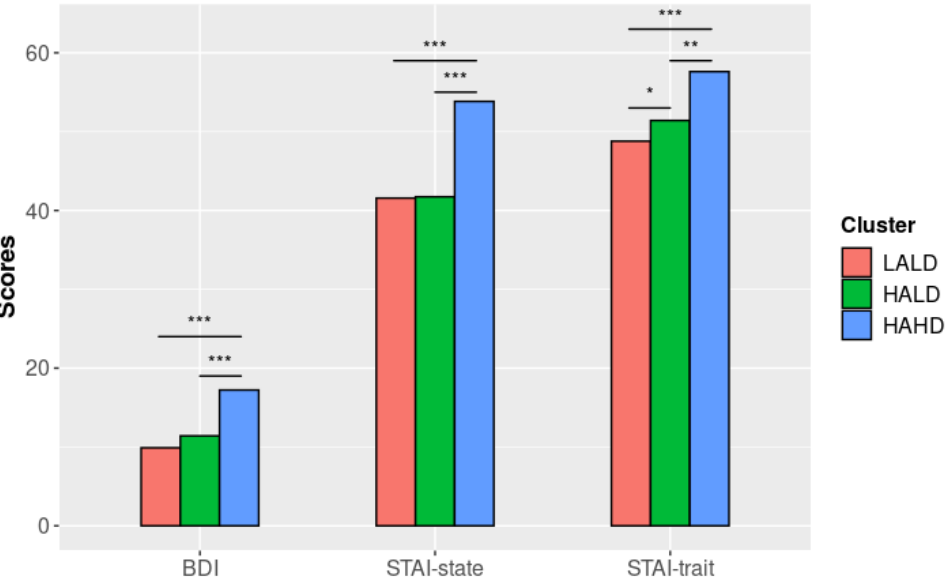
Figure 2. BDI, STAI-A, and STAI-B scores by cluster (adjusted models). Note. LALD : “Low Alcohol Low Dissociation” subgroup; HALD : “High Alcohol Low Dissociation” subgroup; HAHD : “High Alcohol High Dissociation” subgroup; BDI : Beck Depression Inventory; STAI : State–Trait Anxiety Inventory; *: p < 0.05; **: p < 0.01; ***: p < 0.001.